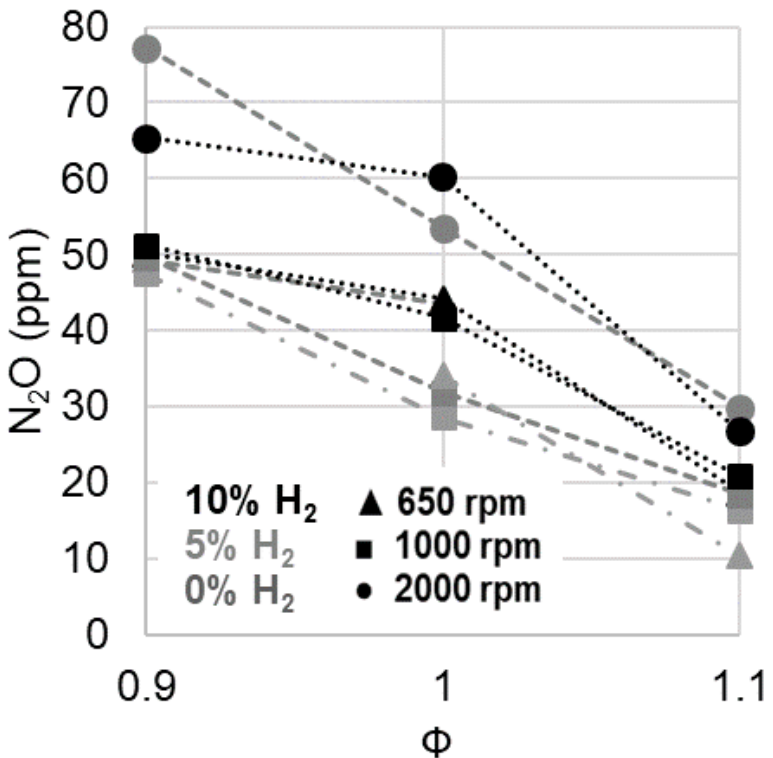
Figure 6. N 2 O emissions vs equivalence ratio for different engine speeds and H 2 content, P in = 1 bar.